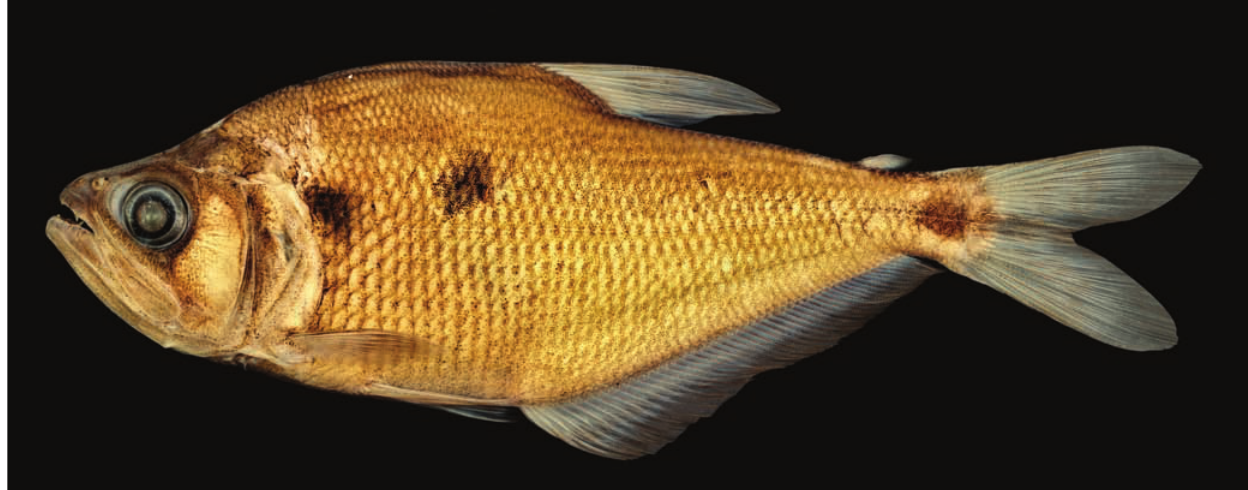
Fig. 10. Charax delimai, MZUSP 81505, holotype, mature male, 100 mm SL, Brazil, Amazonas, community of São Pedro, rio Tiquié, rio Negro